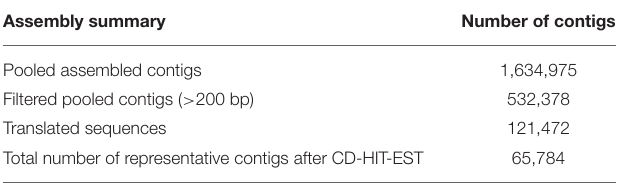
TABLE 1 | Summary of Illumina sequencing assembly of B. amphitrite . TABLE 2 | Summary of annotated